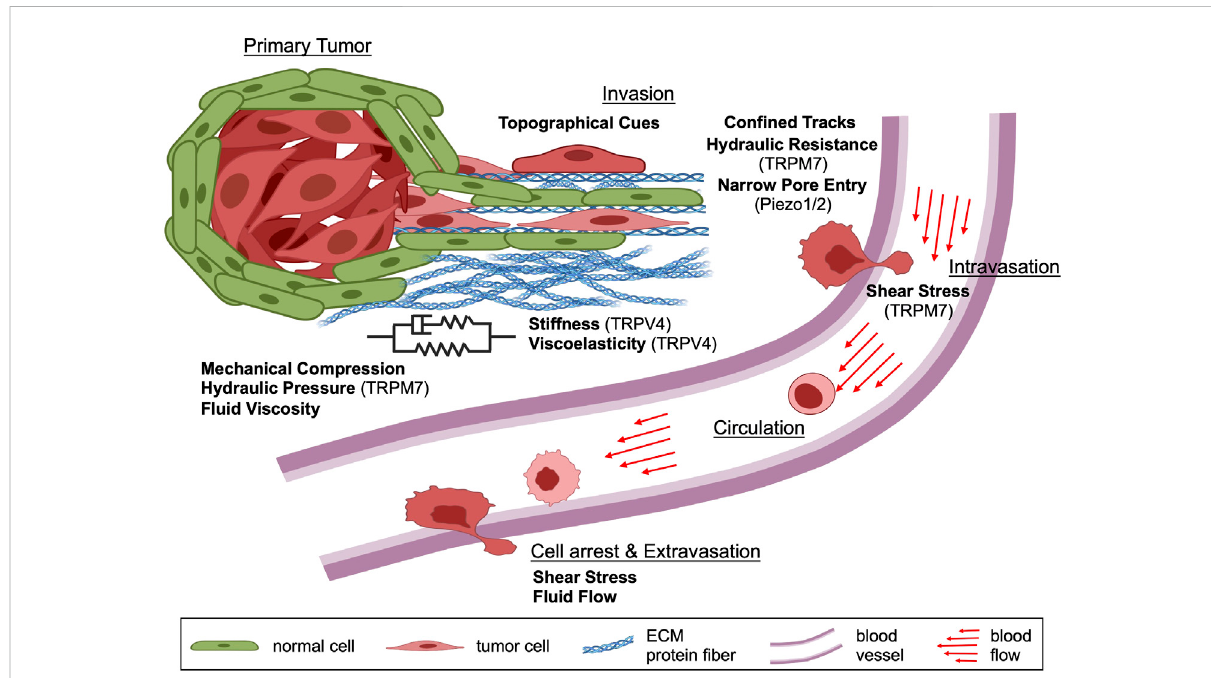
FIGURE 1 Schematic depicting the contribution of various physical cues during different steps of the metastatic cascade. In the primary tumor, cancer cellsexperiencemechanicalcompressionandhydraulicpressureaswellasdifferentlevelsofsubstratestiffness,viscoelasticityandextracellular fl uid viscosity. Following primary tumor cell dissemination, invading cancer cells encounter substrate stiffness and viscoelasticity, mechanical compression, fl uid viscosity, solid barriers, con fi ned tracks, and other topographies within the local tissue microenvironment. During intravasation, cancer cells experience shear stress caused by blood fl ow and continue to be exposed to this physical cue while in circulation. The viscosity of blood is also elevated relative to interstitial fl uids, which potentially impacts cell behavior. As cancer cells arrest to the vascular endothelium and extravasate out of the bloodstream, they experience shear stress from the blood fl ow. Taken together, cancer cells are exposed to many different physical forces during the metastatic cascade which they must sense, integrate and interpret to engage appropriate cellular mechanisms for ef fi cient dissemination. Schematic created with